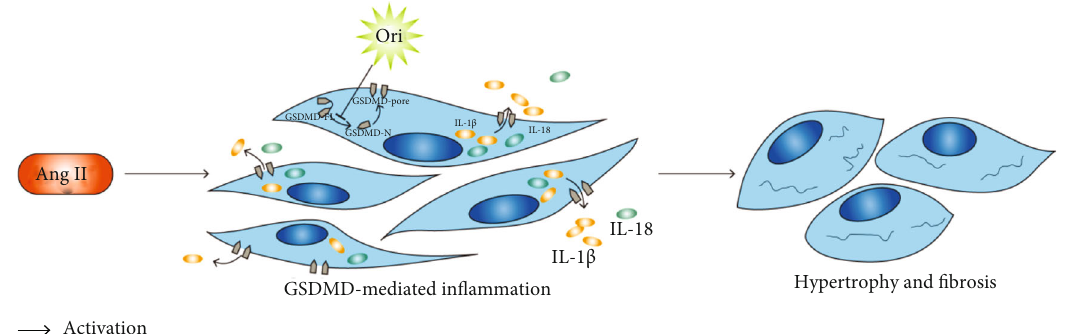
Figure 5: The mechanism schematic of oridonin attenuating cardiac remodeling by inhibiting GSDMD-mediated in fl